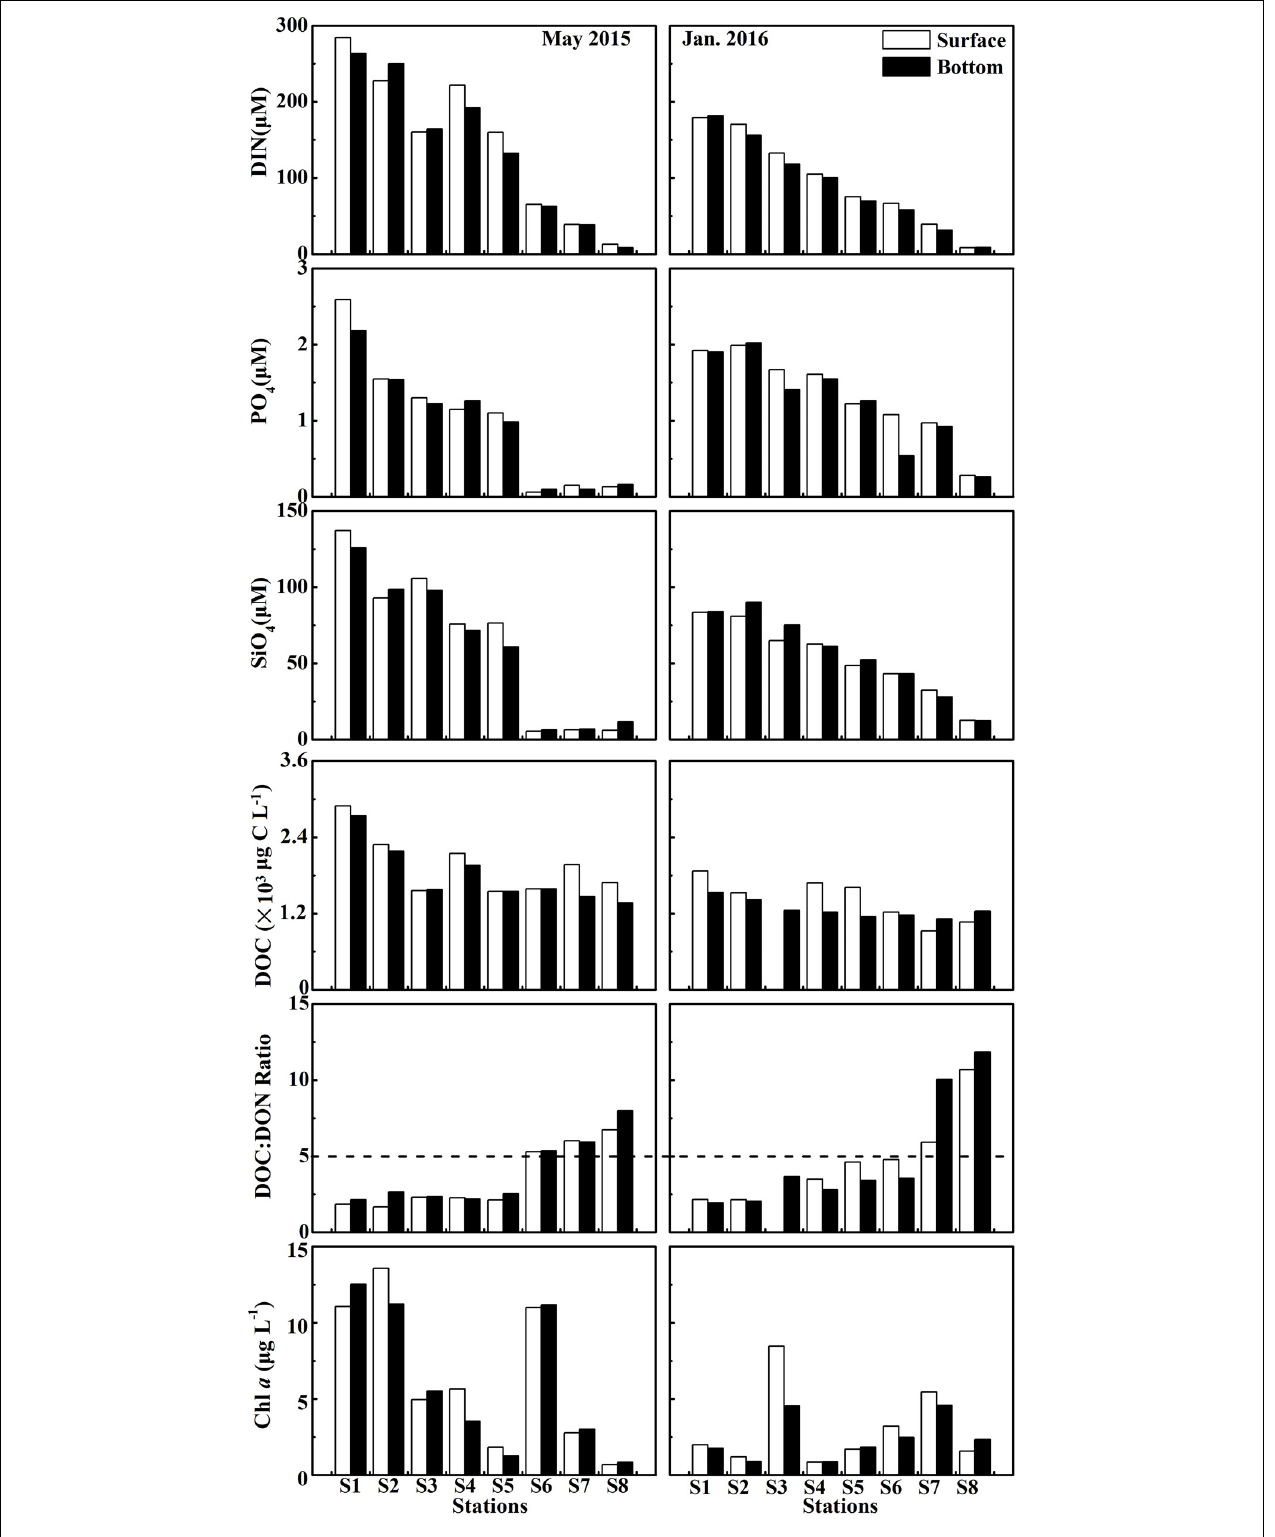
FIGURE 4 | DIN, PO 4 , SiO 4 , DOC, Chl a concentrations and the ratio of DOC to DON at the surface and bottom at eight stations in the wet season (May 2015) and the dry season (January 2016). DIN = NO 3 + NO 2 + NH 4 .